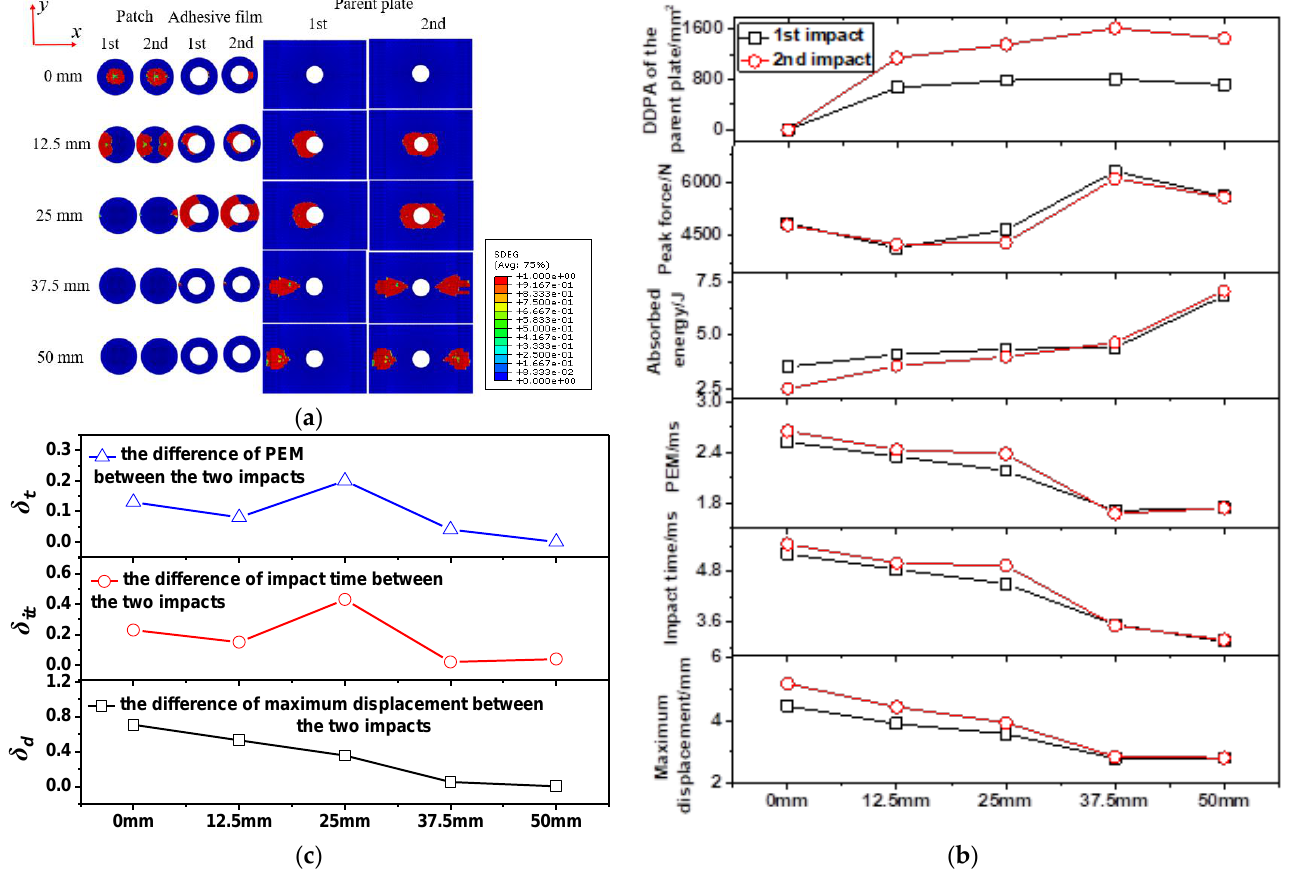
Figure 14. Delamination damage diagrams of the repaired specimen ( a ), impact parameter curves under double impacts at impact distances of 0 mm–50 mm, with the impact energy of 10 J, ( b ) and difference curves of impact parameters (c) . Table 4 . Impact parameters under double impacts at impact distances of 0 mm – 50 mm, with the impact energy of 10 J. Simula-